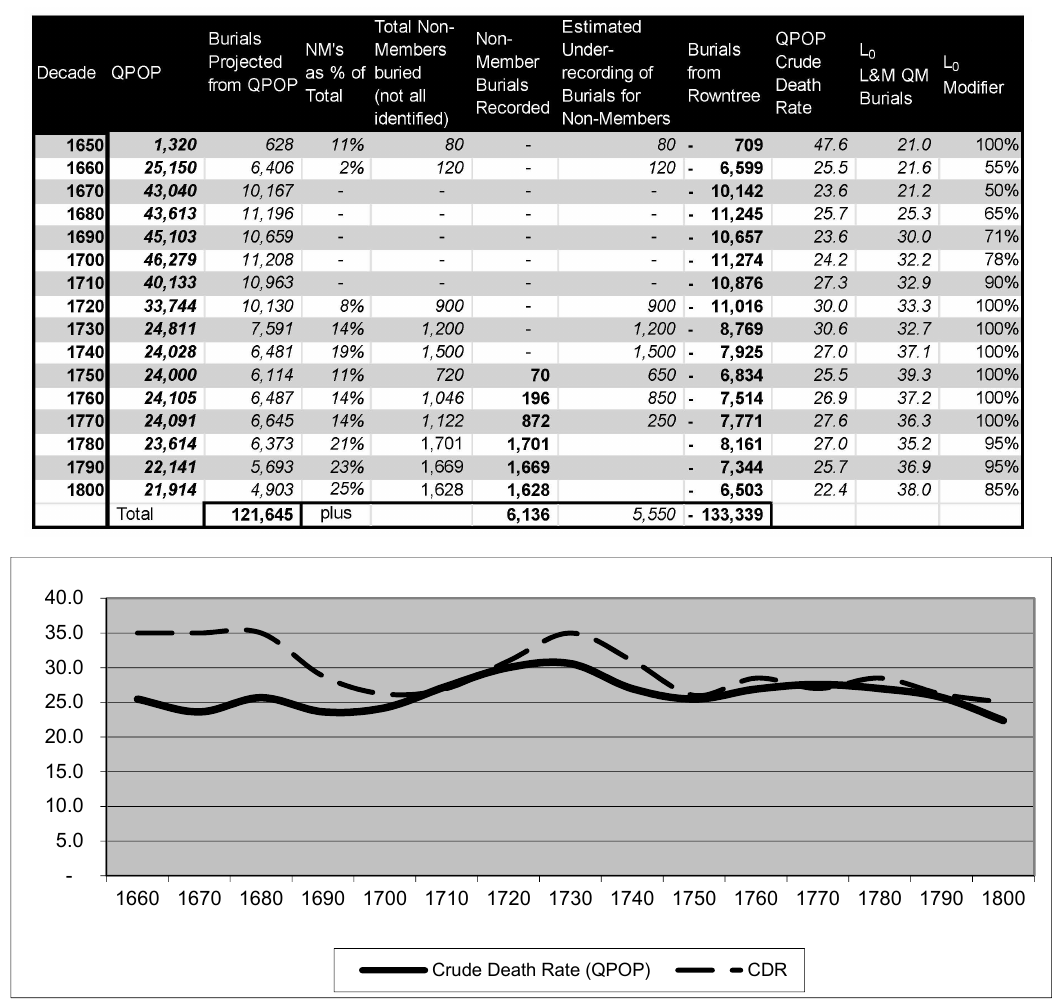
Figure 6. Modified crude death rate (CDR) used for QPOP vs. general CDR (Wrigley).